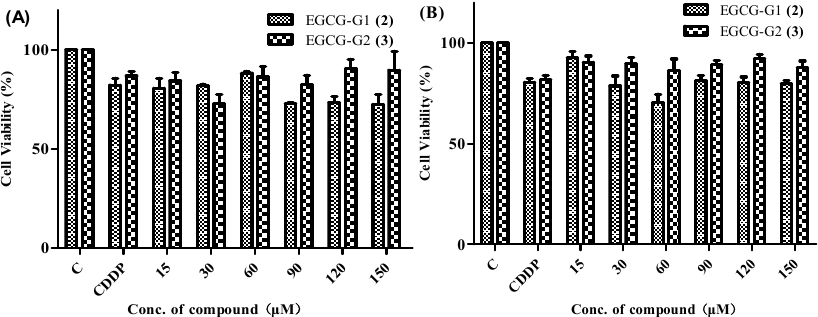
Figure 3. In vitro anticancer activity of EGCG glycosides: EGCG-G1 ( 2 ) and EGCG-G2 ( 3 ). MTT cell viability assays of human breast cancer cell lines MCF-7 ( A ) and MDA-MB-231 ( B ) treated with cisplatin (CDDP), EGCG-G1 ( 2 ) and EGCG-G2 ( 3 ). The cells were seeded in 96-well plates and, after overnight incubation, treated with various agent concentrations for 48 h. The viability values are represented as percentages with respect to the untreated cells (regarded as 100% viability). The bars demonstrate the means of triplicate experiments with SD.